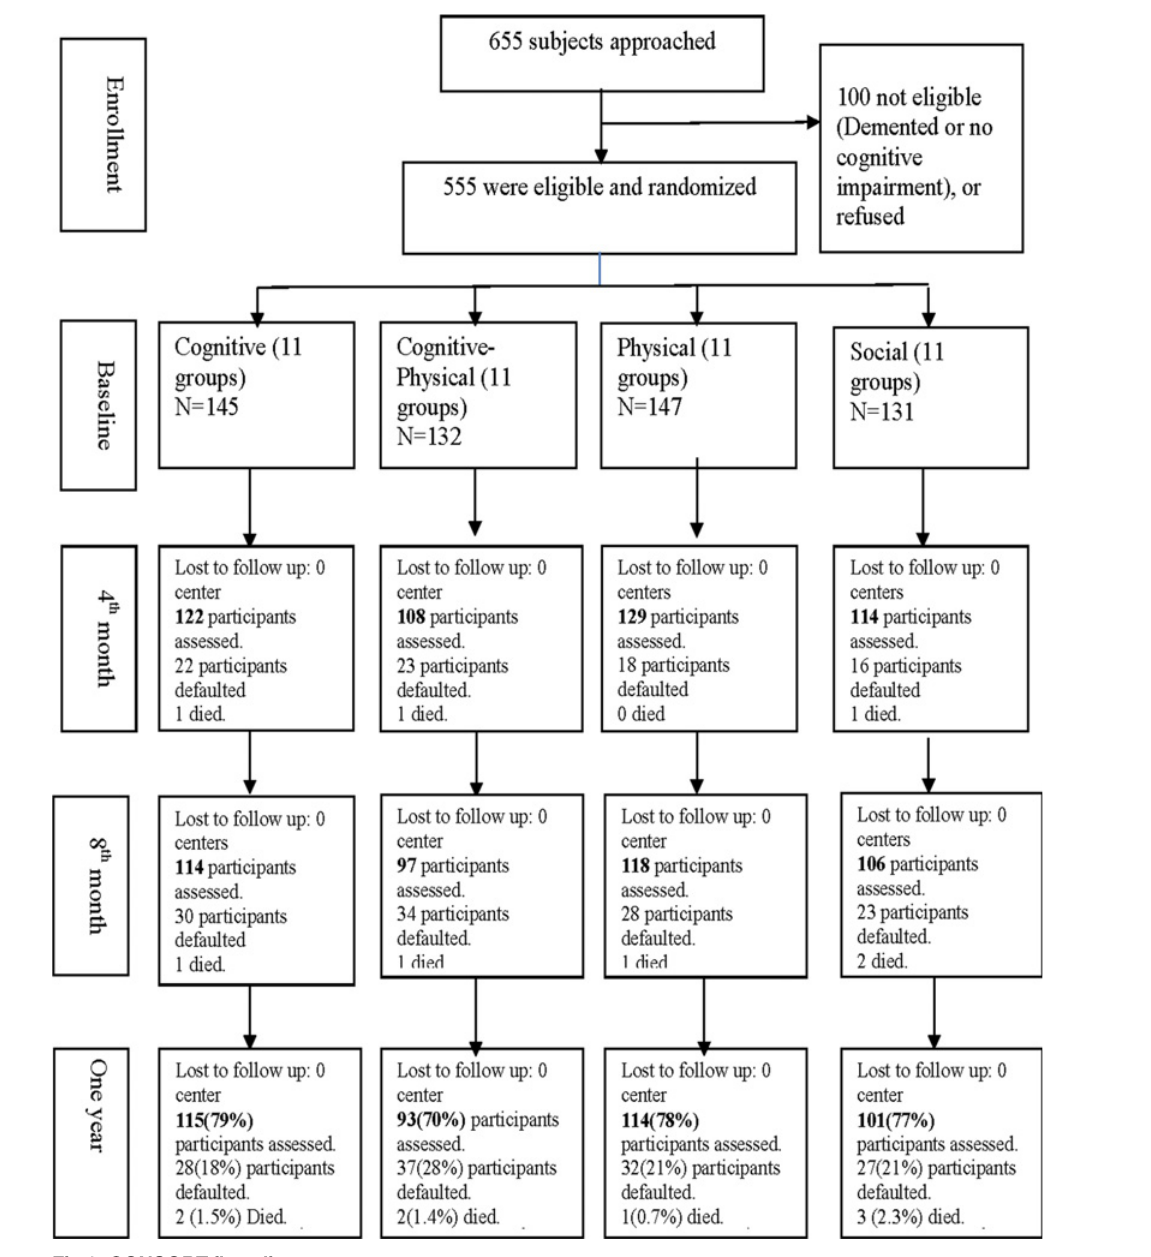
Fig 1. CONSORT flow